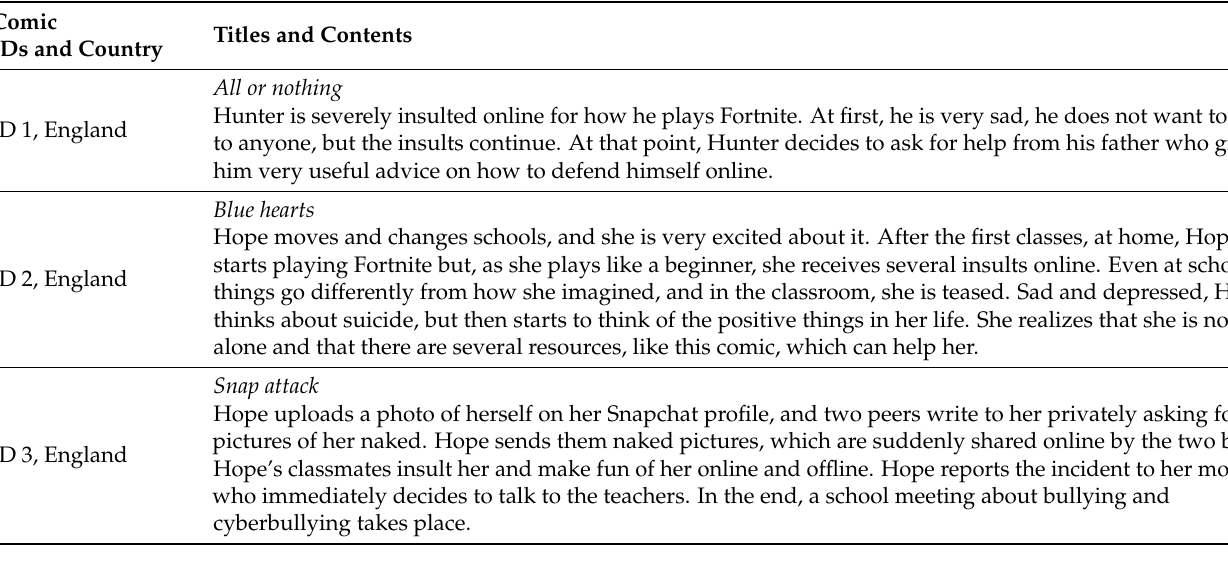
Table 1. Comic IDs, Country origin, titles, and